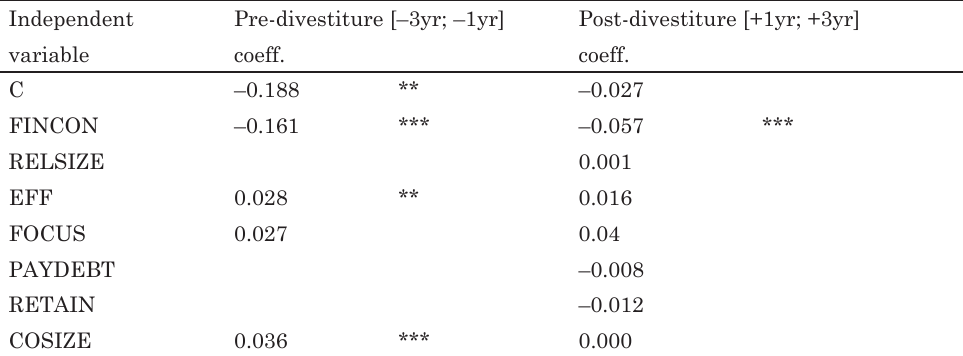
Table 3. Estimates of GLS regressions with ROA as dependent